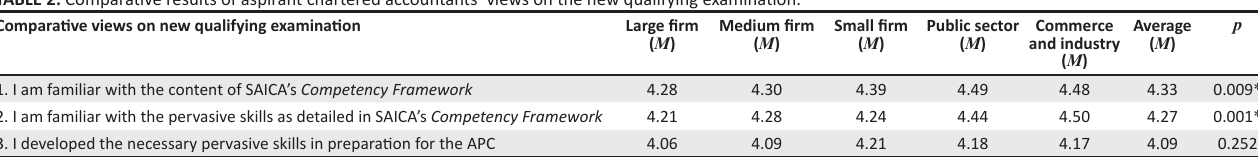
TABLE 2: Comparative results of aspirant chartered accountants’ views on the new qualifying examination. Comparative views on new qualifying